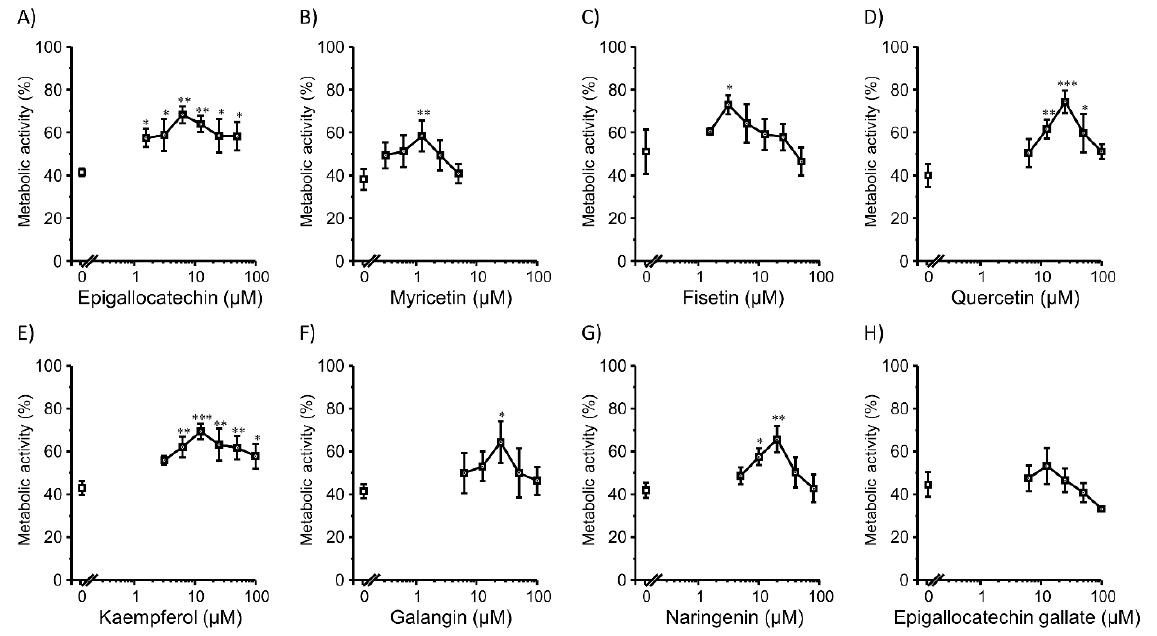
Figure 4. Metabolic activity of cells co-incubated with flavonoids and Lipofectamine ® 3000/plasmid DNA (pcDNA3/GL 0.2 µg/well) complexes in 2D HepG2 cells. ( A ) Epigallocatechin (0–50 µM). ( B ) Myricetin (0–5 µM). ( C ) Fisetin (0–50 µM). ( D ) Quercetin (0–100 µM). ( E ) Kaempferol (0–100 µM). ( F ) Galangin (0–100 µM). ( G ) Naringenin (0–80 µM). ( H ) Epigallocatechin gallate (0–100 µM). Each dot represents the mean ± SD ( n = 3). * p < 0.05, ** p < 0.01, *** p < 0.001 compared with the control (0 µM flavonoids).